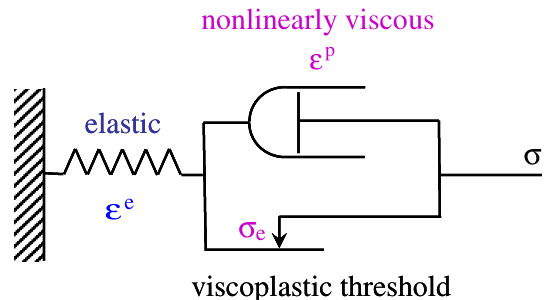
Fig. 3. Schematic representation of the elastic-viscoplastic